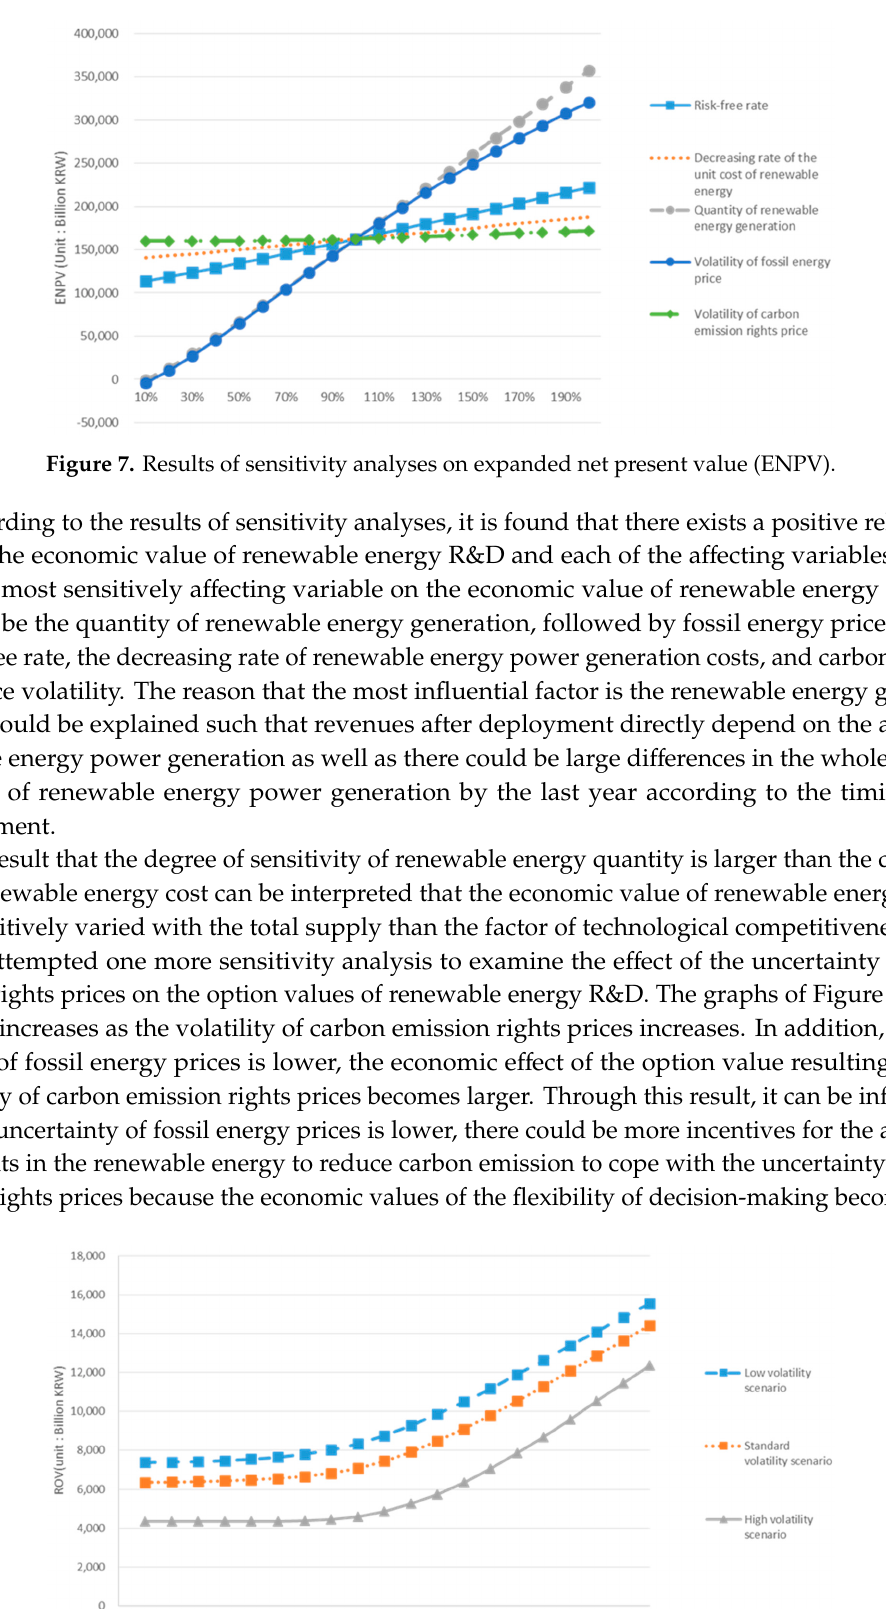
15 of 19 Figure 6. Two-dimensional optimal decision lattice considering fossil energy prices uncertainty (A: abandonment, D: deployment, R: R&D investment)3.3. Sensitivity analysis. Among the factors that affect the economic value of renewable energy R&D, the following